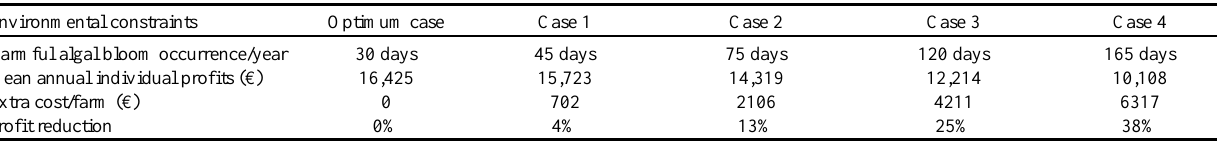
Table 9 . Economic effects of harmful algal blooms